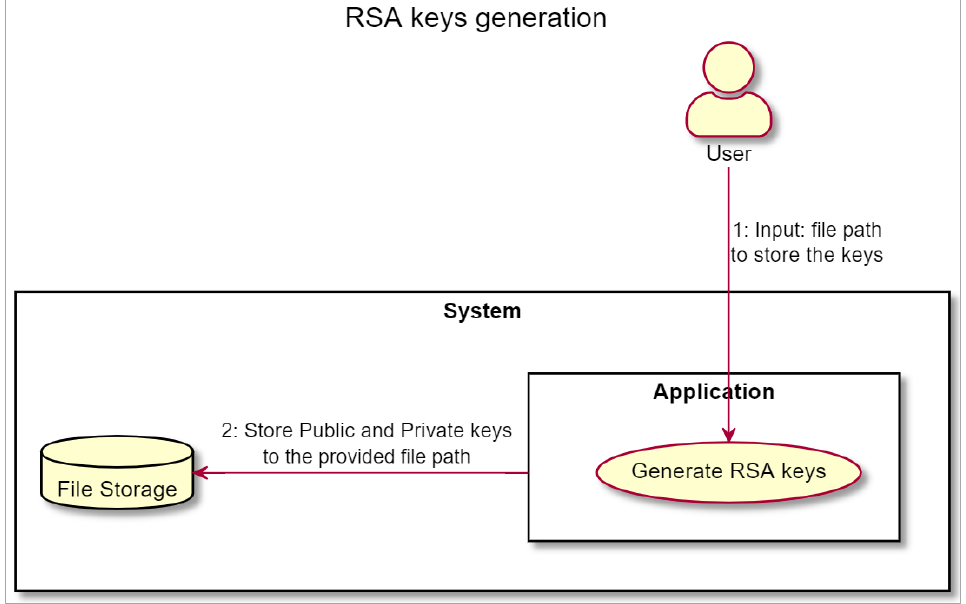
Figure 3. RSA Key Generation (2048